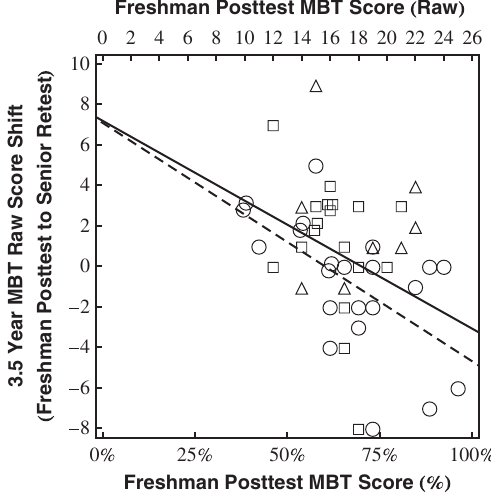
FIG. 3. Score shift from the end of freshman mechanics to graduation on the MBT versus freshman posttest score. The solid line is a fit to the data for all groups of students, the dashed line fits the group 1 students only. The x intercepts of the fits (70.0% and 60.0%, respectively) are clearly not consistent with zero or